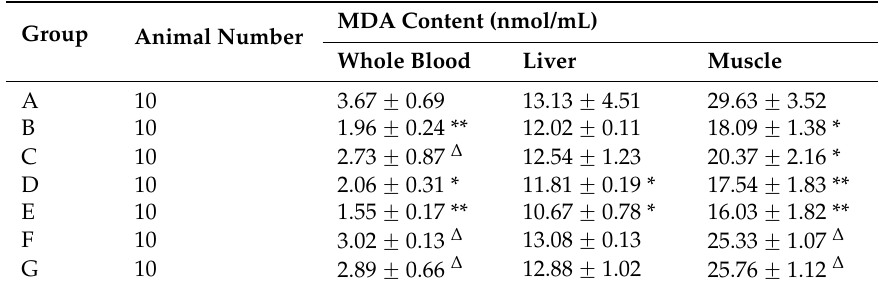
Table 8. Fe-HPH II chelate and malondialdehyde (MDA) content in rat blood, liver, and muscle. MDA Content (nmol/mL) Group Animal Number Whole Blood Liver